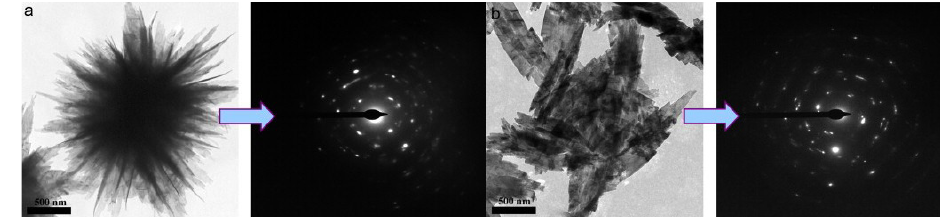
Figure 5. TEM and SAED images of flower-like and leaf-like CuO nanosheets prepared in a reflux